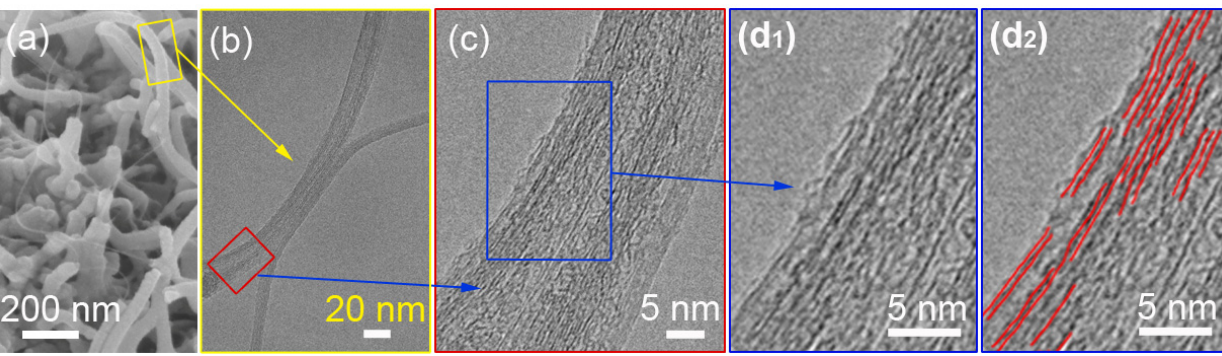
Figure 10. ( a ) Scanning electron micrograph (SEM) of PAN tubular coating on SWNT. High-resolution transmission electron micrograph (HR-TEM) of tubular coated PAN/SWNT samples; ( b ) at the onset of electron beam exposure; ( c and d of the PAN/SWNT sample where the PAN lattice of ~0.52 nm is observed; and ( d schematic highlighting the PAN lattice observations in ( d